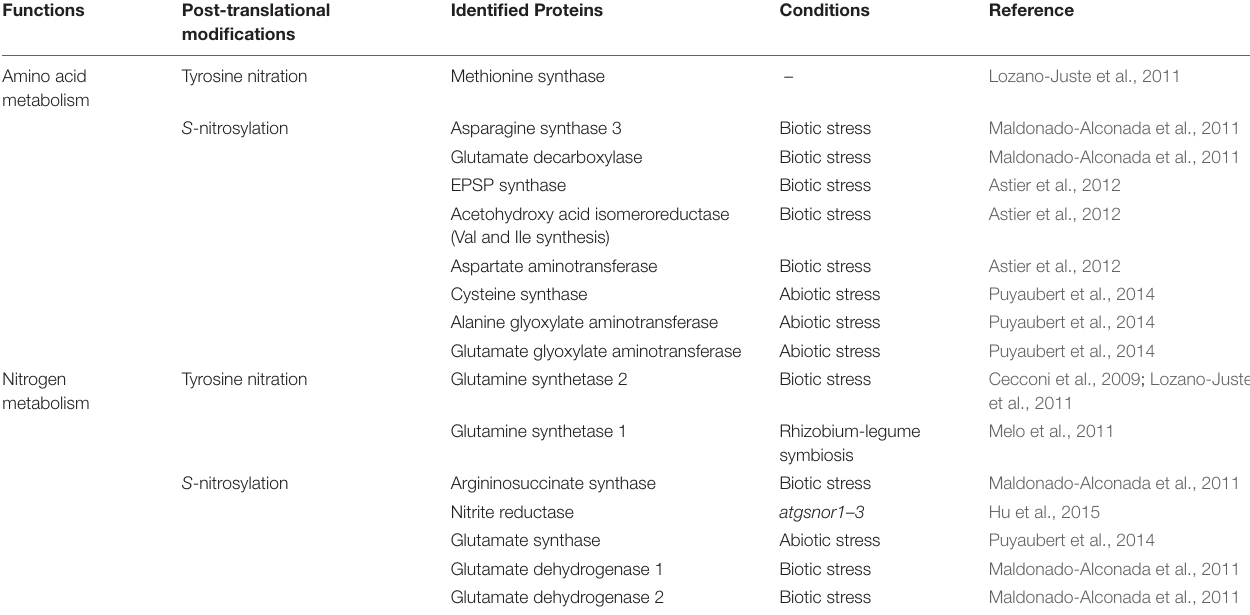
TABLE 1 | Examples of S -nitrosylated or Tyr-nitrated proteins involved in N and amino acid metabolism.